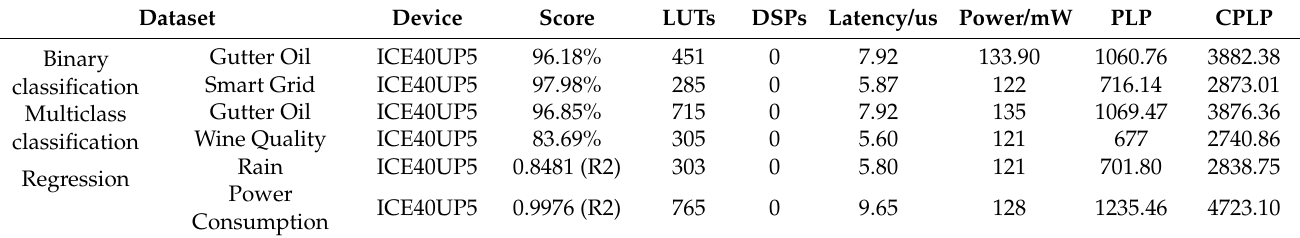
Table 10. DT deployment results on the best CPLP-performing FPGAs.